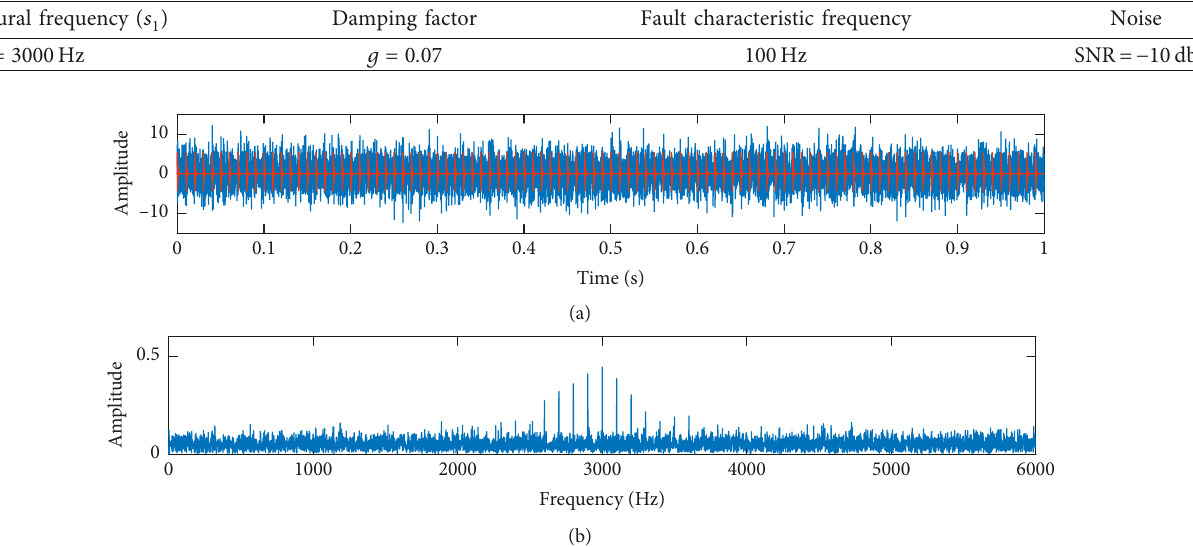
Table 2: Parameters of simulation signal in case study 1.